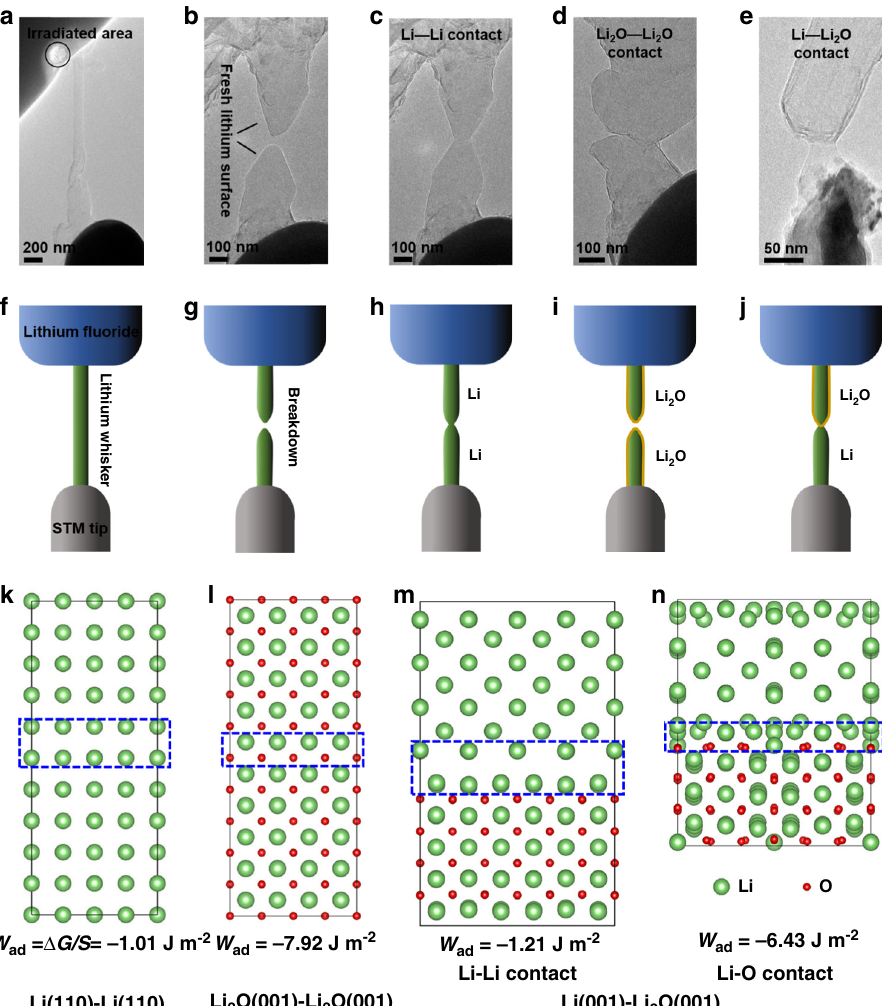
Fig. 6 Contact property of lithium metal and surface oxide layer. a Formation of lithium whisker with the help of an STM tip. The black circle represents the area where initial lithium particles were formed. b Breakdown of the lithium whisker, and two fresh lithium tips are obtained. c Li – Li contact. d Li 2 O-Li 2 O contact. e Li – Li 2 O contact. f – j Corresponding schematics of ( a – e ). k Li(110)-Li(110) interface model, l Li 2 O(001)-Li 2 O(001) interface model, m Li(001)-Li 2 O (001) with Li – Li contact at the interface, n Li(001)-Li 2 O(001) with Li – O contact at the interface. The interface regions are labeled by blue dotted